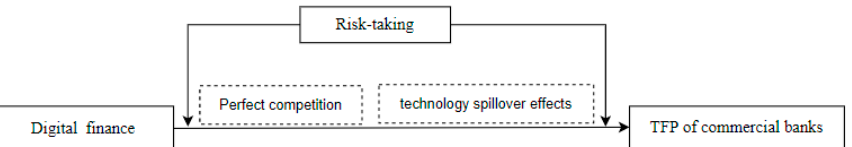
Figure 1. Theoretical